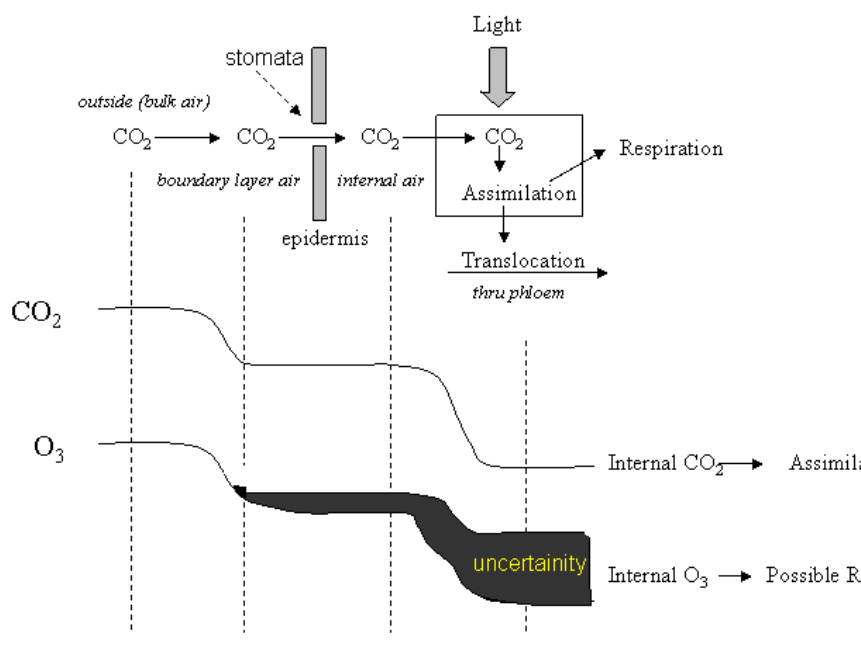
FIGURE 2 . Pathway and relative concentration of ozone and CO 2 movement into leaf tissue. The pathways of both gases are shown left to right following the structures presented above. The concentrations of the gases are shown in relative terms up and down, with the higher level representing the higher concentration. It should be noted that there is an uncertainty of the level of ozone within the leaf due to the types of reactions that ozone may undertake. No measurement has been made of ozone within the leaf, rather either breakdown of ozone when exposed to leaf tissue[7] or the loss of ozone that pass through the leaf[8] are measured.